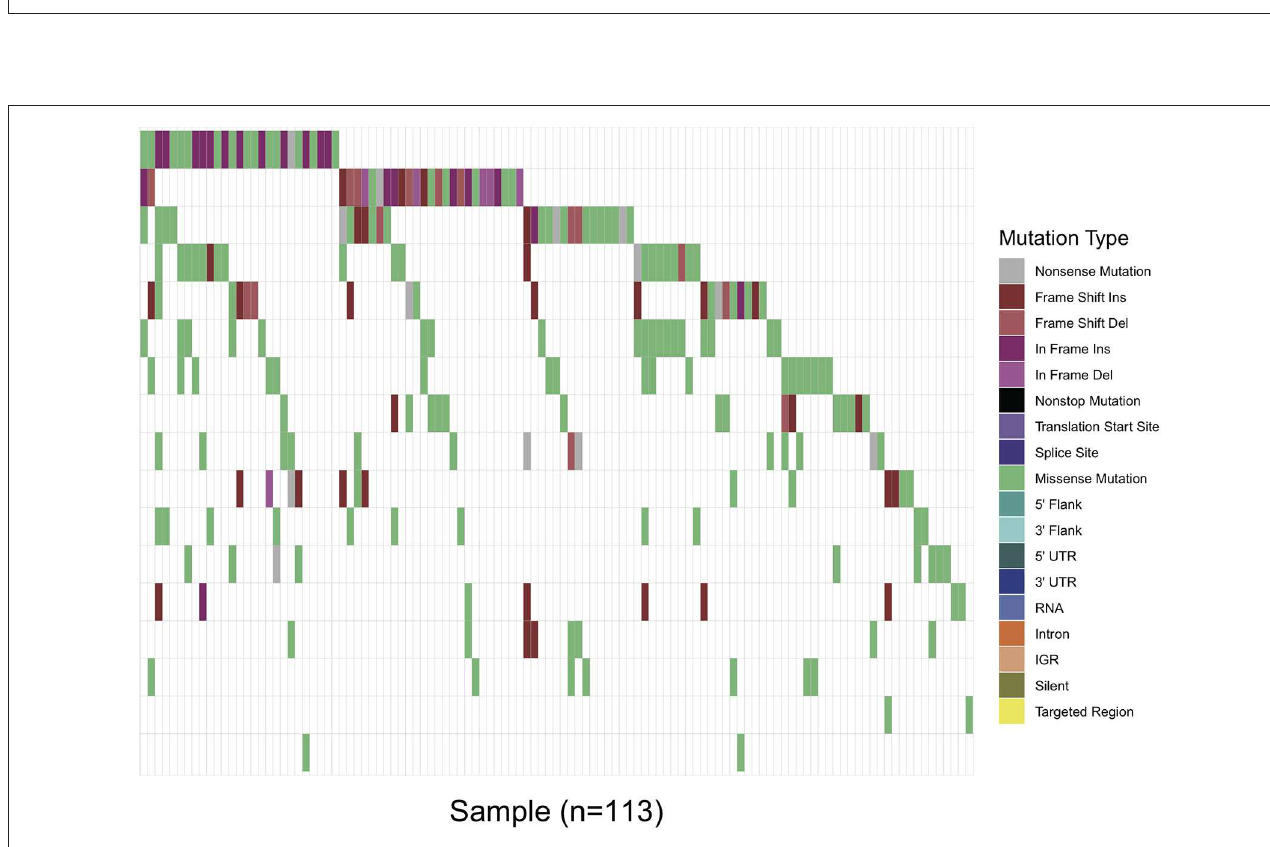
FIGURE 2 | Waterfall plot of the detailed gene mutation spectrum of 113 AML patients. Each variant subtype is labeled with a unique color. The upper panel demonstrates the mutational burden per megabase DNA (MB) for each patient.